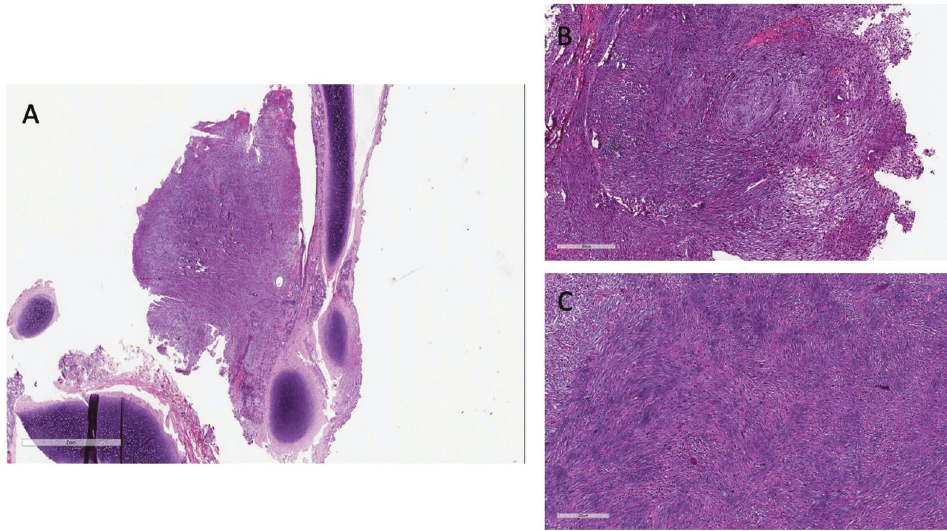
Fig. 4 The endobronchial lesion is seen at low magni fi cation (20 (cid:3) ) as a polypoid mass protruding in the bronchial lumen ( A ); the lesion has a moderate cellularity with a fi brohistiocytic appearance composed by spindle cells (myo fi broblasts) and a variable numbers of plasma cells, lymphocytes, histiocytes admixed; the stroma is focally myxoid (magni fi cation 200 (cid:3) ) ( B, C